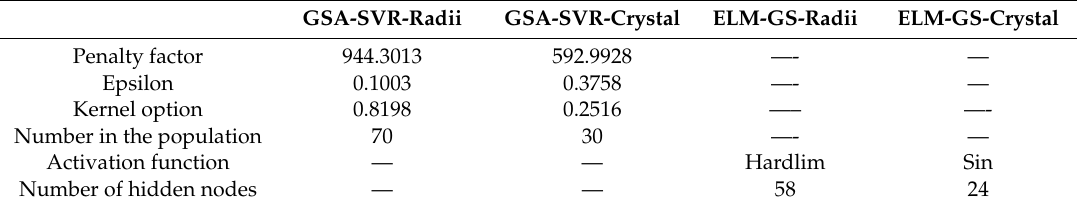
Figure 1. Dependence of convergence of GSA-SVR-radii model on the density of search space. Table 2. Optimum hyperparameters of support vector regression (SVR)-based models as obtained using a gravitational search algorithm (GSA) and extreme learning machine (ELM)-based models as obtained using grid search